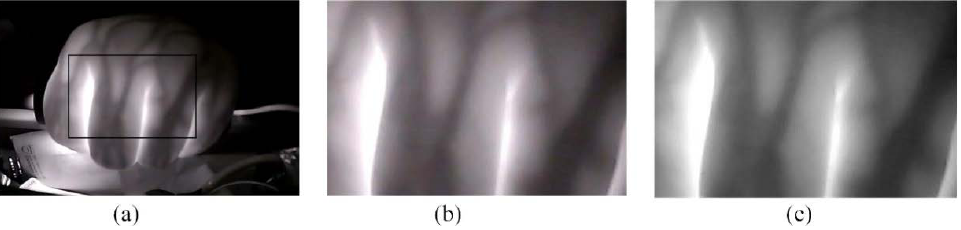
Figure 2. Vein transmission image. ( a ) Original transmission image, ( b ) ROI image, ( c ) ROI image after performing the gray-scale operation.